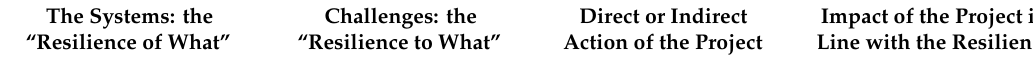
Table 3. Challenges and the resilience strategy and impact of the project